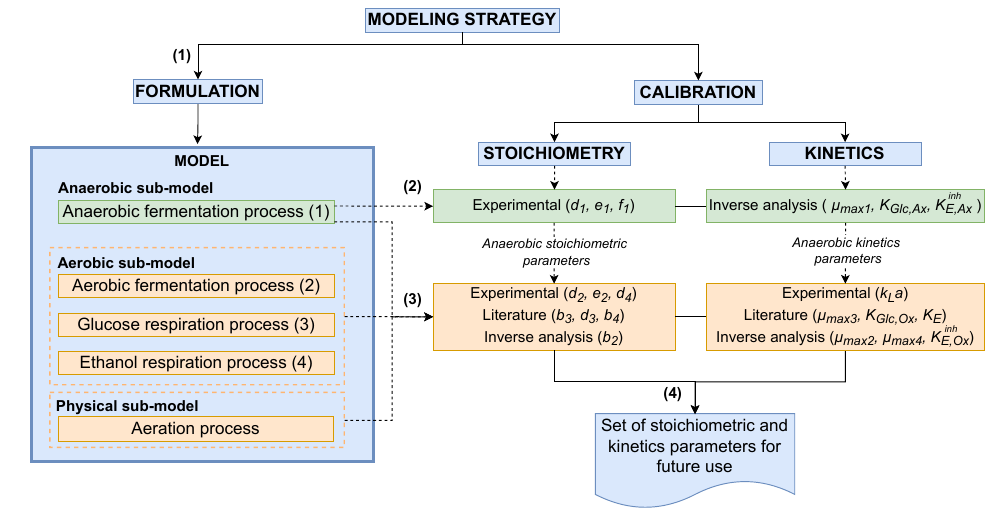
Figure 4. Modeling